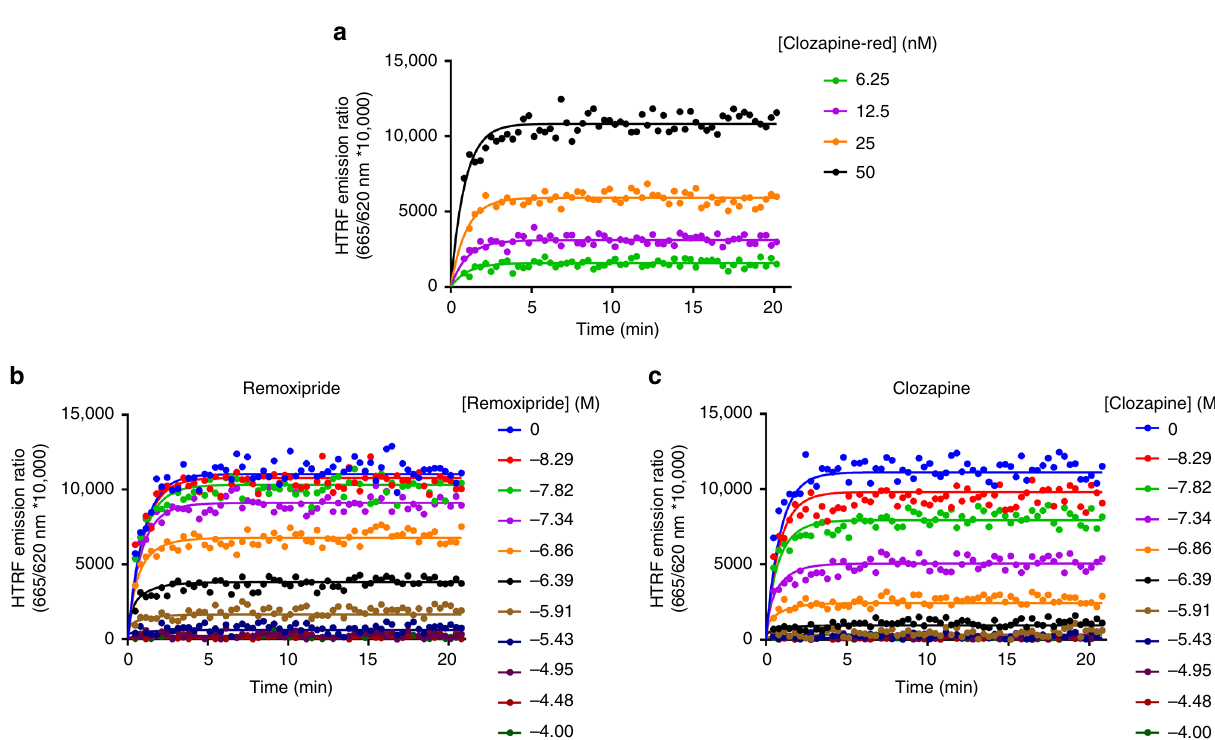
Fig. 2 Determination of tracer and unlabelled compound kinetic parameters. a Observed association of clozapine-red to the human dopamine D 2L receptor. Data presented in singlet from a representation of 4 experiments. Clozapine-red competition association curves in the presence of b remoxipride and c clozapine. All binding reactions were performed in the presence of GppNHp (100 μ M) and non-speci fi c binding levels determined by inclusion of haloperidol (10 μ M). Kinetic data were fi tted to equations previously described to calculate k on and k off values for the unlabelled ligands; these are summarized in Table 1. Data are presented as singlet values from a representative of three to four experiments. All data used in these plots are detailed in Table 1